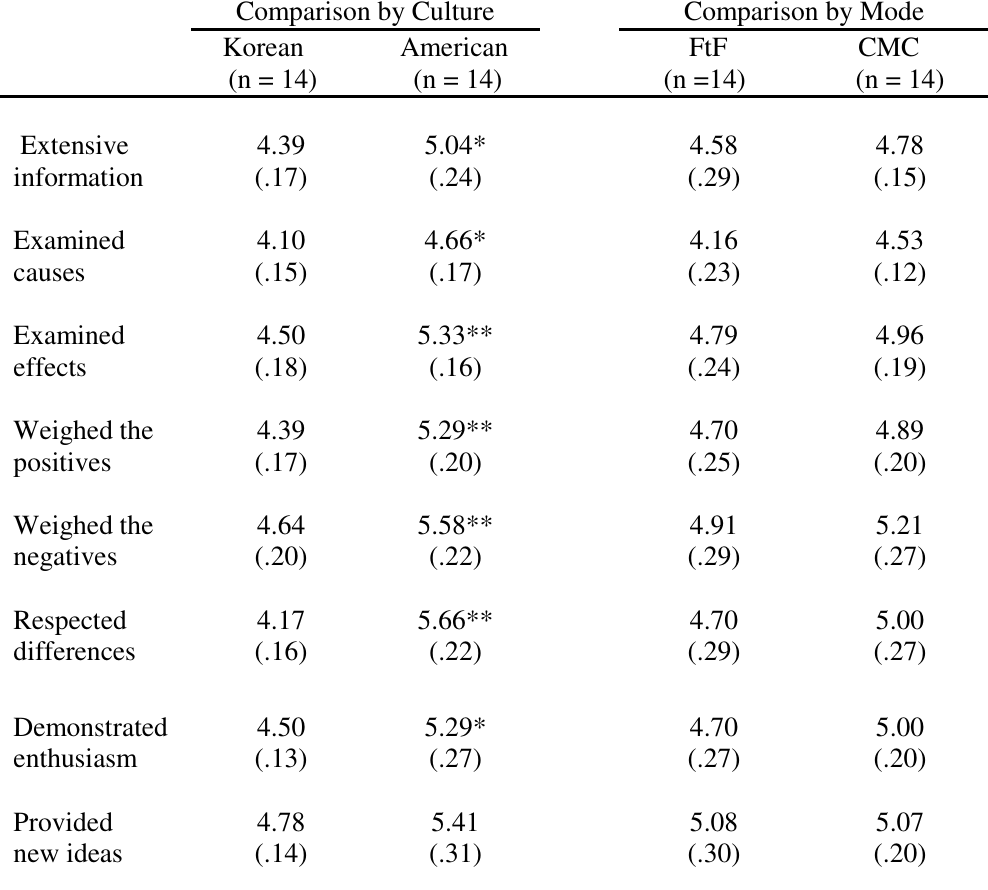
Table 2 . Judges’ Evaluation of Deliberation by Culture and Mode Comparison by